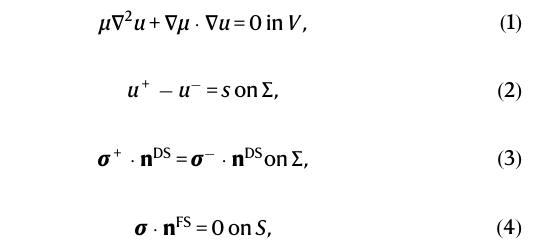
c Estimated surface displacements. d Estimated surface strains. In ( c ) and ( d ), blue and orange lines indicate Models 2A and 2B, respectively. Solid and dashed lines indicate PINN and FEM solutions,